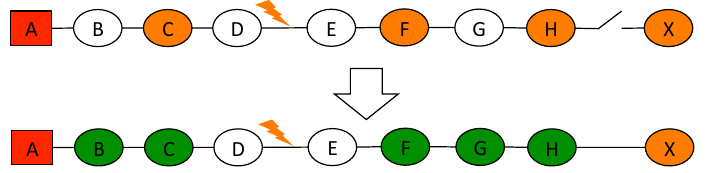
Figure 14. Automatic selection of a failure with the improved 4G DAS procedure.